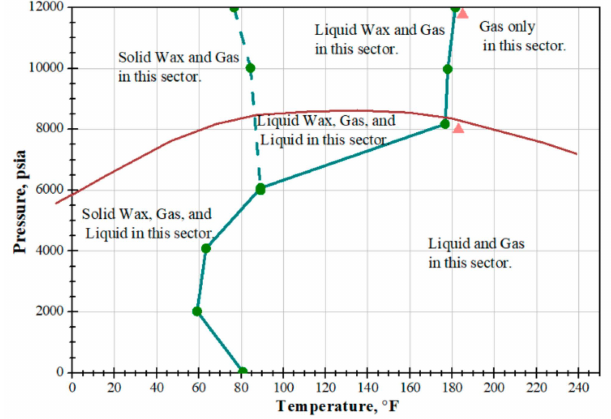
Figure 2. Phase envelope of a typical condensate oil system